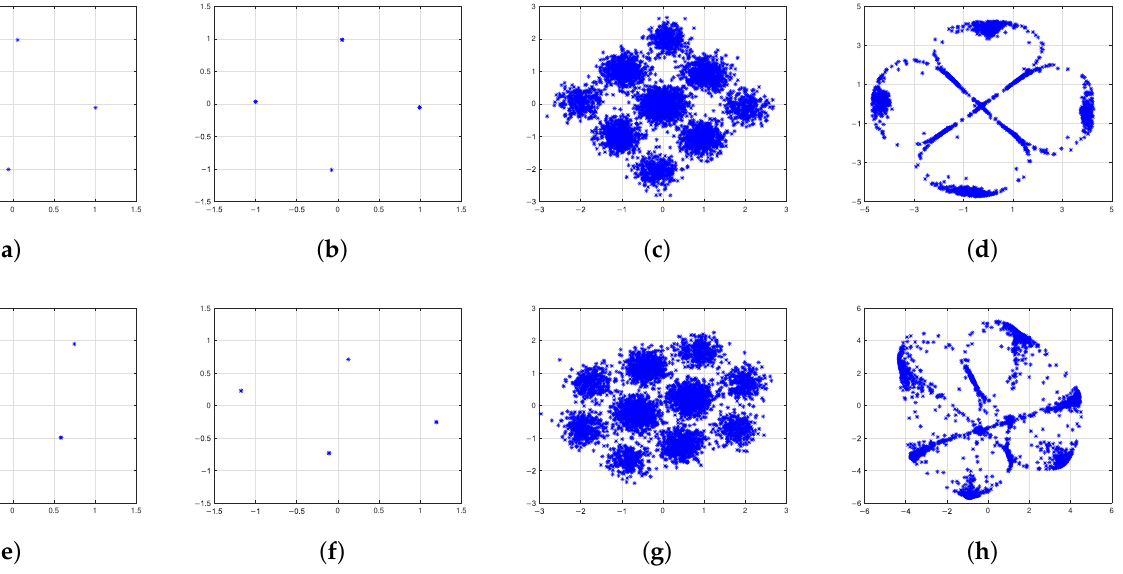
Figure 3. Constellations generated after the training processes. Each row of subfigures shows a group of representative training outputs of our DNN-based PNC model during different training. ( a , e ) encoder A output; ( b , f ) encoder B output; ( c , g ) relay input; ( d , h ) relay